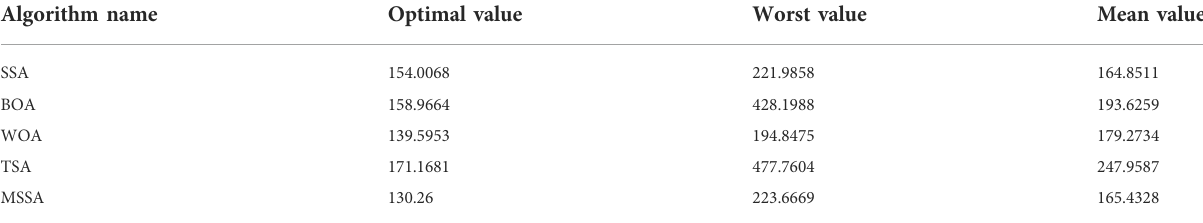
TABLE 9 Statistical data of experimental results in environment 1.